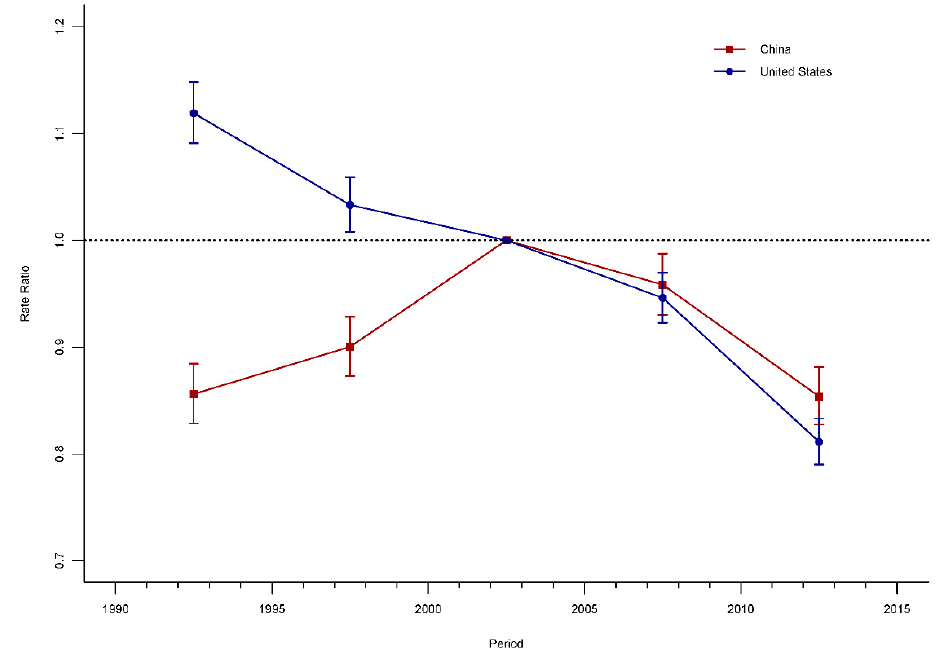
Figure 4. Period RRs of road-injury mortality rate adjusted for age and birth cohort effects, compared to the referent period (2000–2004) and the corresponding 95% CI.